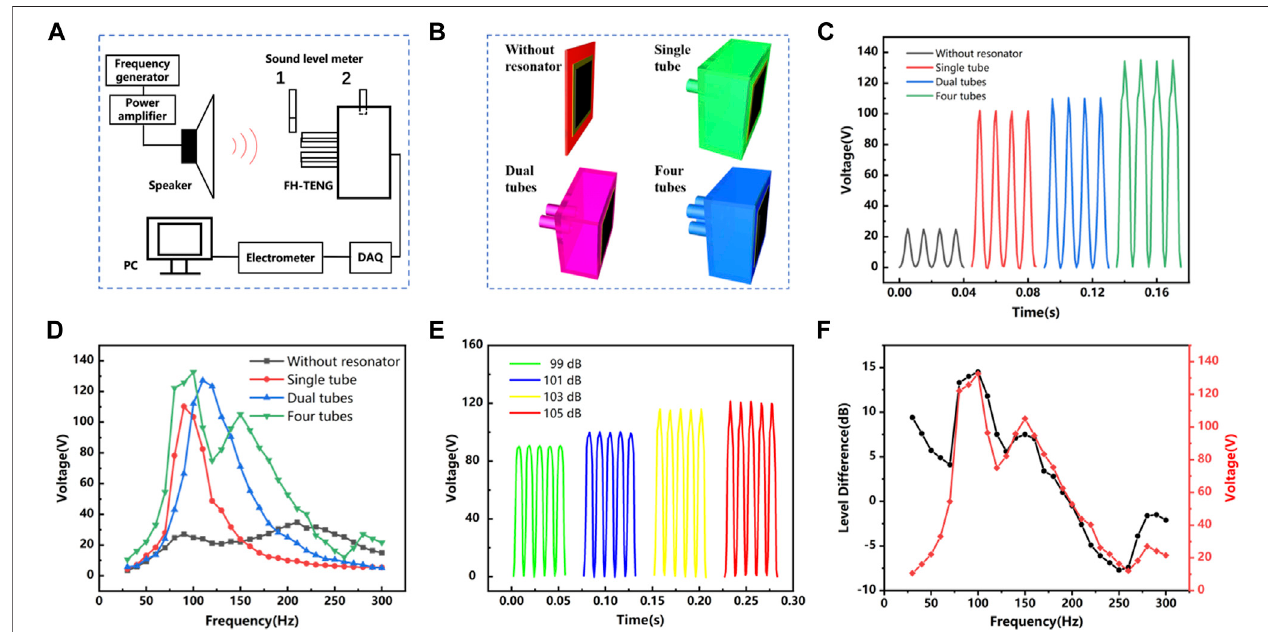
FIGURE 4 | Electricity generation performance experiments of sound-driven MH-TENG (A) Schematic diagram of power generation experiments (B) Schematic diagramoftheTENGswithoutaresonator,withsingle-tube Helmholtzresonator,withdual-tubeHelmholtzresonator,andwithfour-tube Helmholtzresonator. (C) V oc of TENGs driven by the same incident sound waves (D) The peak V oc of TENGs under a frequency range of 30 – 300 Hz (E) V oc of the MH-TENG driven by the different incident sound waves pressures (F) Ampli fi ed sound pressure level difference and V oc of the MH-TENG.